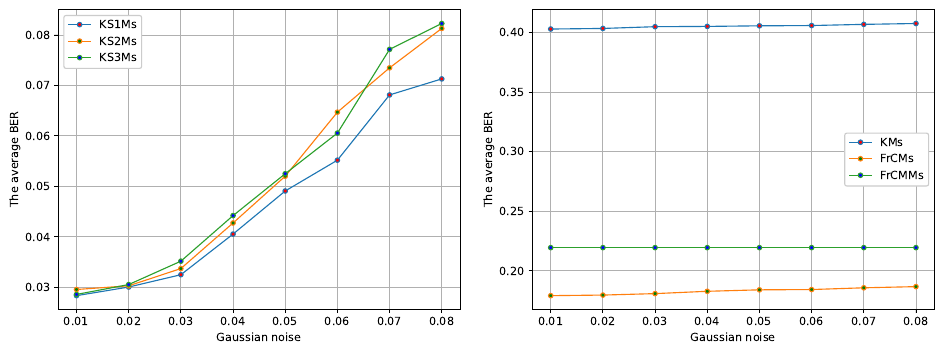
Figure 7. Gaussian noise.